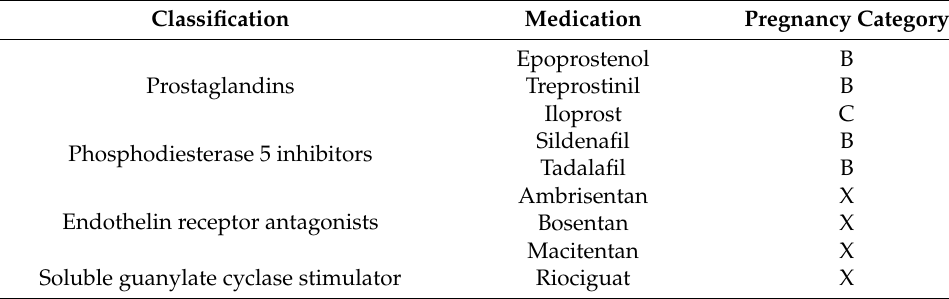
Table 2. Pregnancy category for PAH